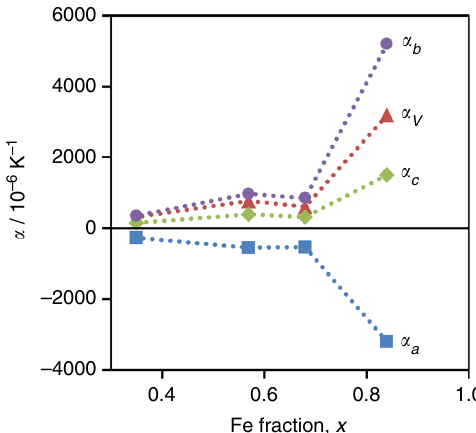
Fig. 5 Maximum coef fi cients of thermal expansion for [Fe x Ni 1 − x ]. These values were calculated using a model fi t to the lattice parameter data. Lines are included as a visual